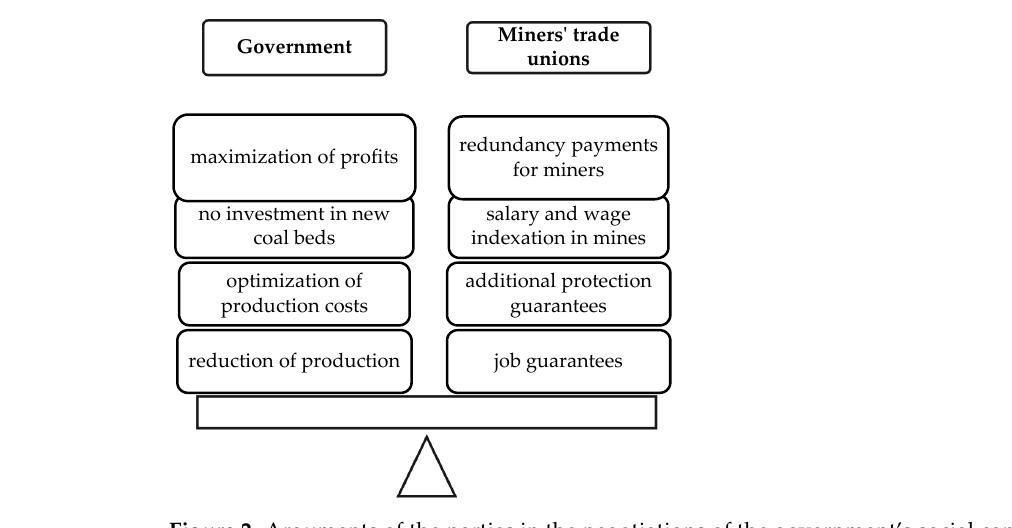
Figure 2. Arguments of the parties in the negotiations of the government’s social contract with the miners’ trade unions. Source: author’s own compilation.